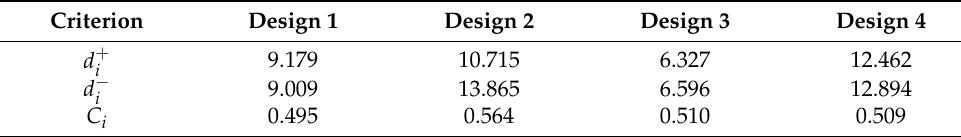
Table 6. The closeness degrees of the designs.